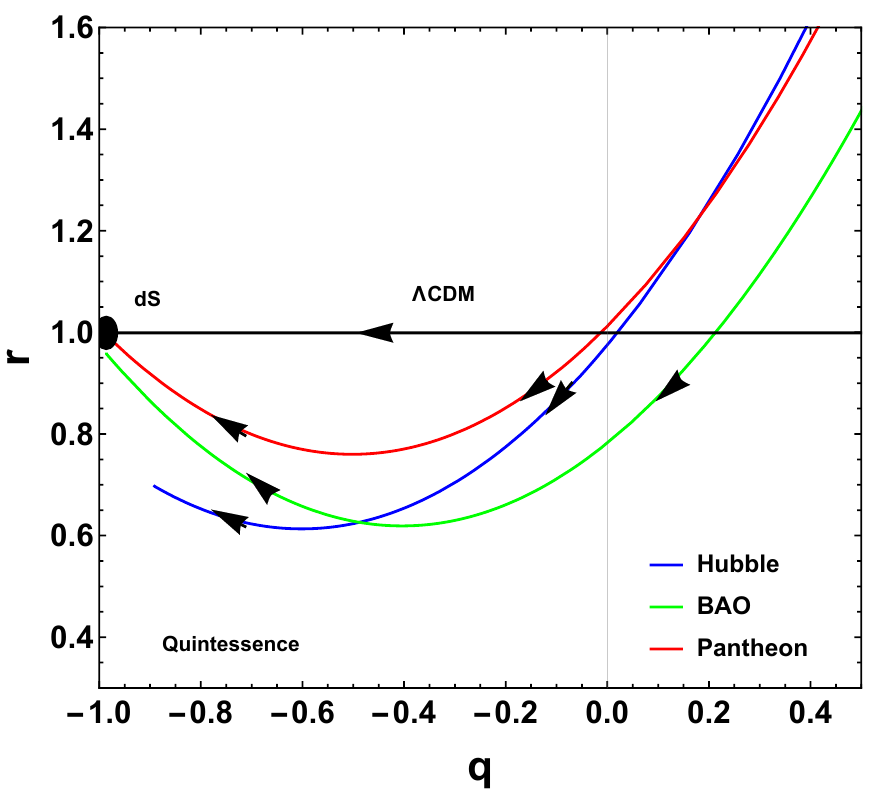
Figure 13. Plot of the trajectories in the q − r plane for the given cosmological model corresponding to the parameter values constrained by the Hubble, BAO, and the Pantheon